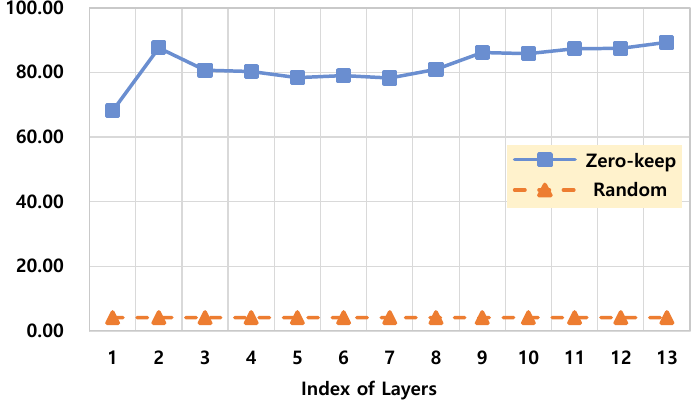
Figure 9. The ratio of skipped multiplications in each layer for the 45% pruning rate on